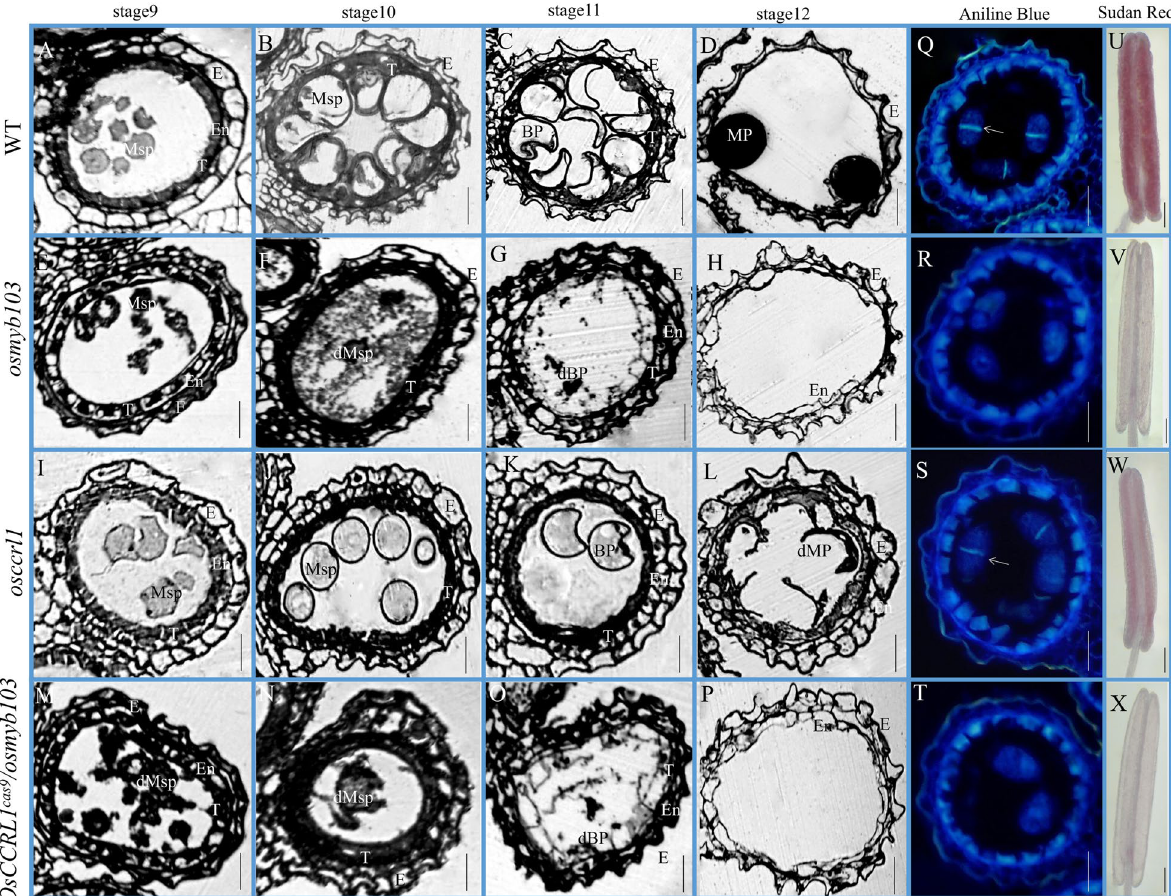
Fig. 8 Semithin section, aniline staining and sudan red staining of the wild type, osmyb103 , osccrl1 , and osmyb103 osccrl1 double mutants. A – P Semi-thin sections of anthers at stages 9, 10, 11 and 12 in the wild type, osmyb103 mutant, osccrl1 mutant, and osmyb103 osccrl1 double mutant. The images show a single locule of an anther. E, epidermis; En, endothecium; T, tapetum; Msp, microspore; BP, bicellular pollen; MP, mature pollen; dMP, mature pollen. Scale bars, 25 μm. Q – T Callose staining of the wild type, osmyb103 mutant, osccrl1 mutant, and osmyb103 osccrl1 double mutant anther at stage 8b. The images show a single locule of an anther. Scale bars, 25 μm. U – X Sudan red of the wild type, osmyb103 mutant, osccrl1 mutant, and osmyb103 osccrl1 double mutant anther. Scale bars, 200